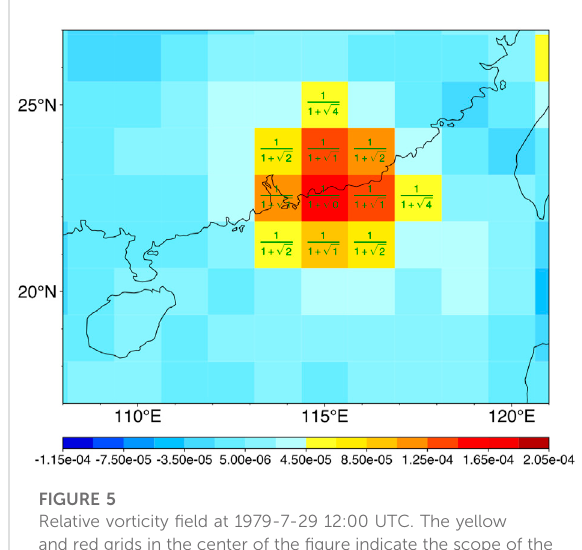
FIGURE 5 Relative vorticity fi eld at 1979-7-29 12:00 UTC. The yellow and red grids in the center of the fi gure indicate the scope of the vortex. The green numbers indicate TC activity frequencies.